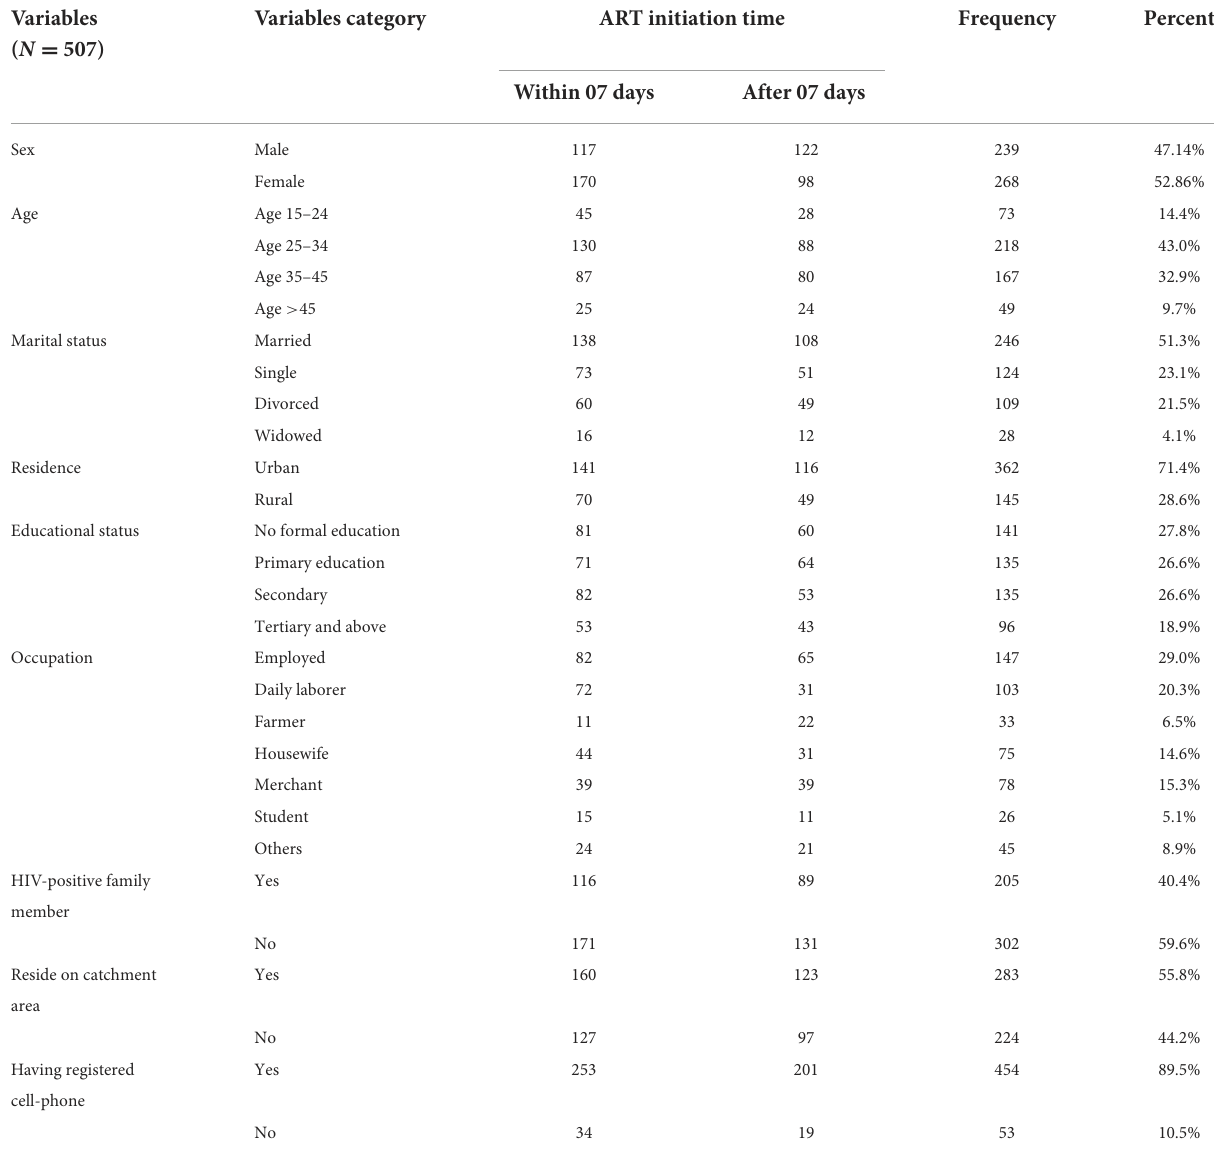
TABLE 1 Socio-demographic characteristics of HIV-positive adults receiving ART by ART initiation time in FHCSH, Northwest Ethiopia,